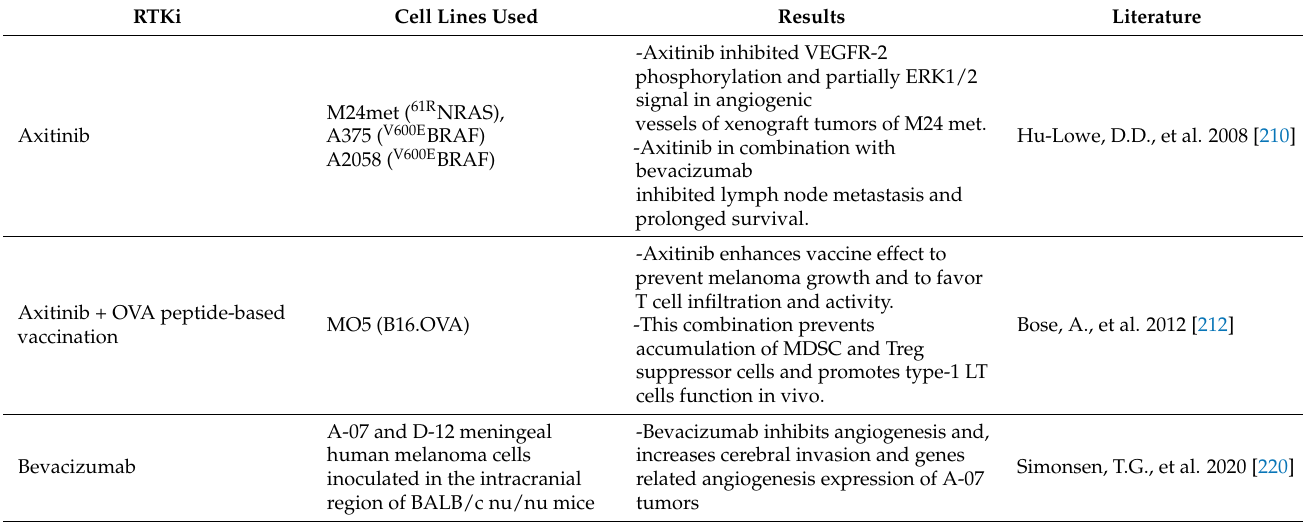
Table 11. Preclinical studies evaluating VEGFR inhibitors in